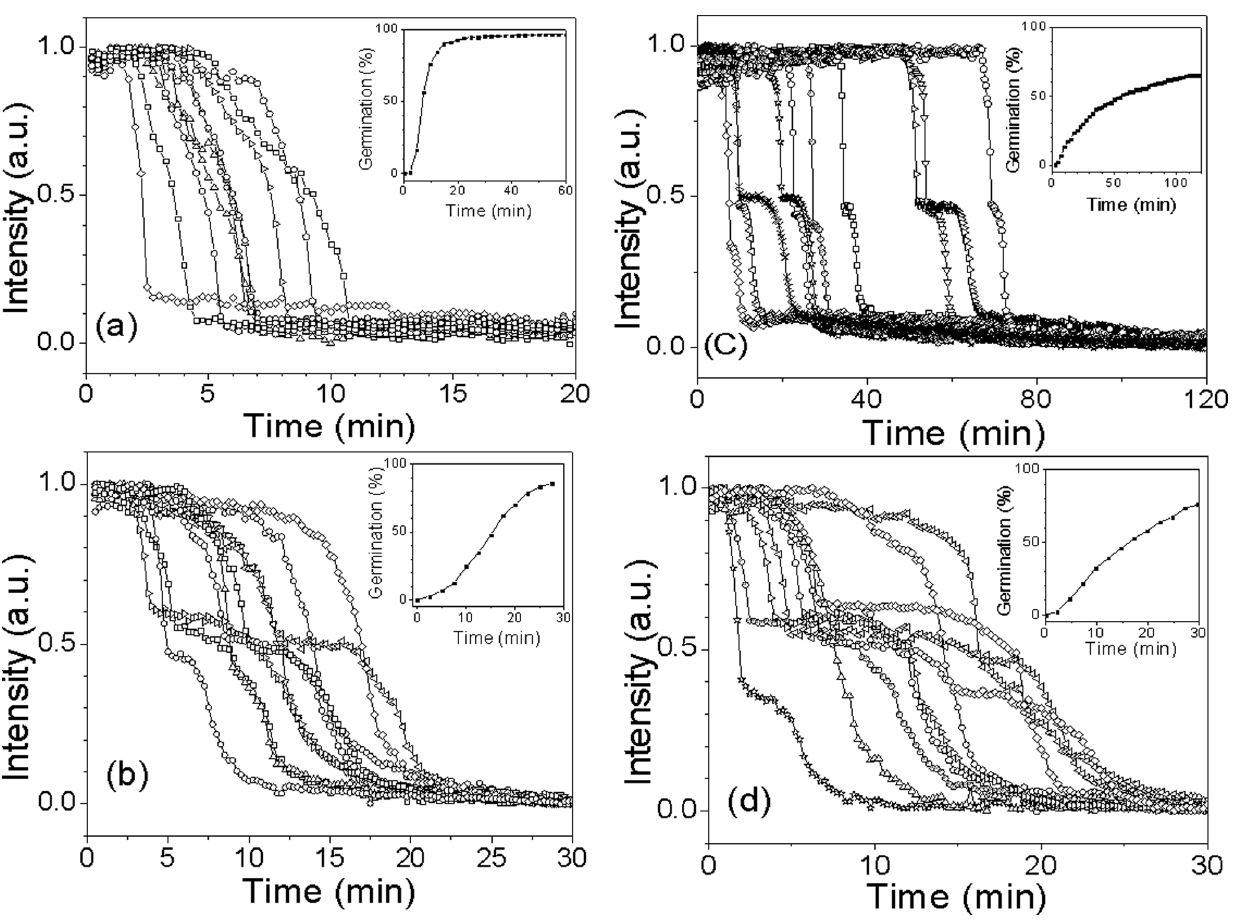
Figure 8. Germination of multiple individual decoated G.stearothermophilus spores. Heat activated (30 min, 100 u C (a,b), or unactivated spores (c,d) were germinated at 65 u C with 1 mM L-valine (a); 1 mM AGFK (b); 60 mM CaDPA (c); and 1 mM dodecylamine (d), in 10 mM sodium phosphate buffer (pH 8.0), and germination of individual spores was monitored by DIC microscopy as described in Methods. The insets in the various panels show the percentages of spore germination when $ 224 individual spores (Table 2) were monitored.